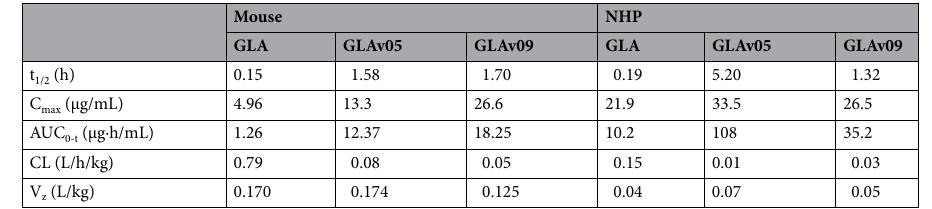
Table 2. Mouse and Cynomolgus monkey plasma PK parameters represented by calculated half-life (t 1/2 ), peak concentration in plasma (C max ), area under the curve (AUC), clearance (CL), and volume of distribution (V z